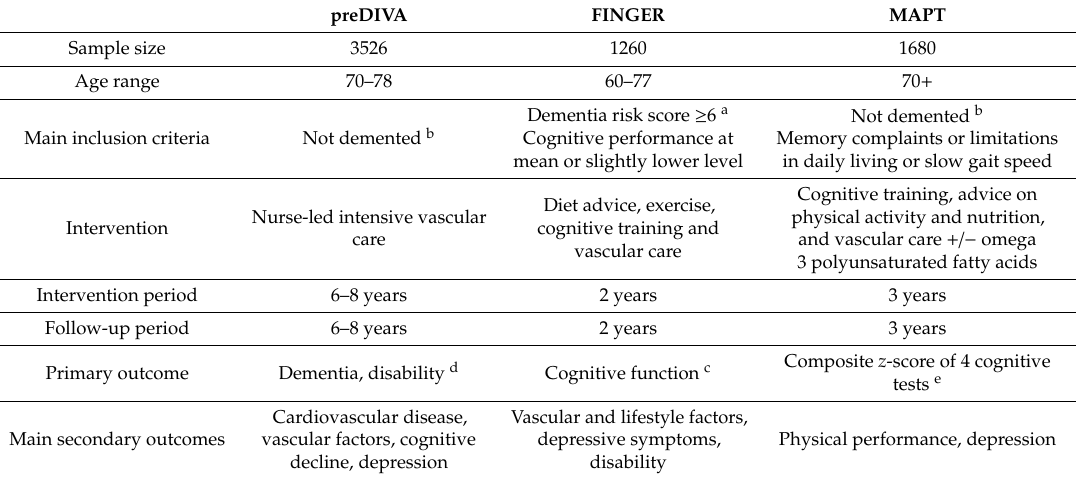
Table 1. Multi-domain dementia prevention